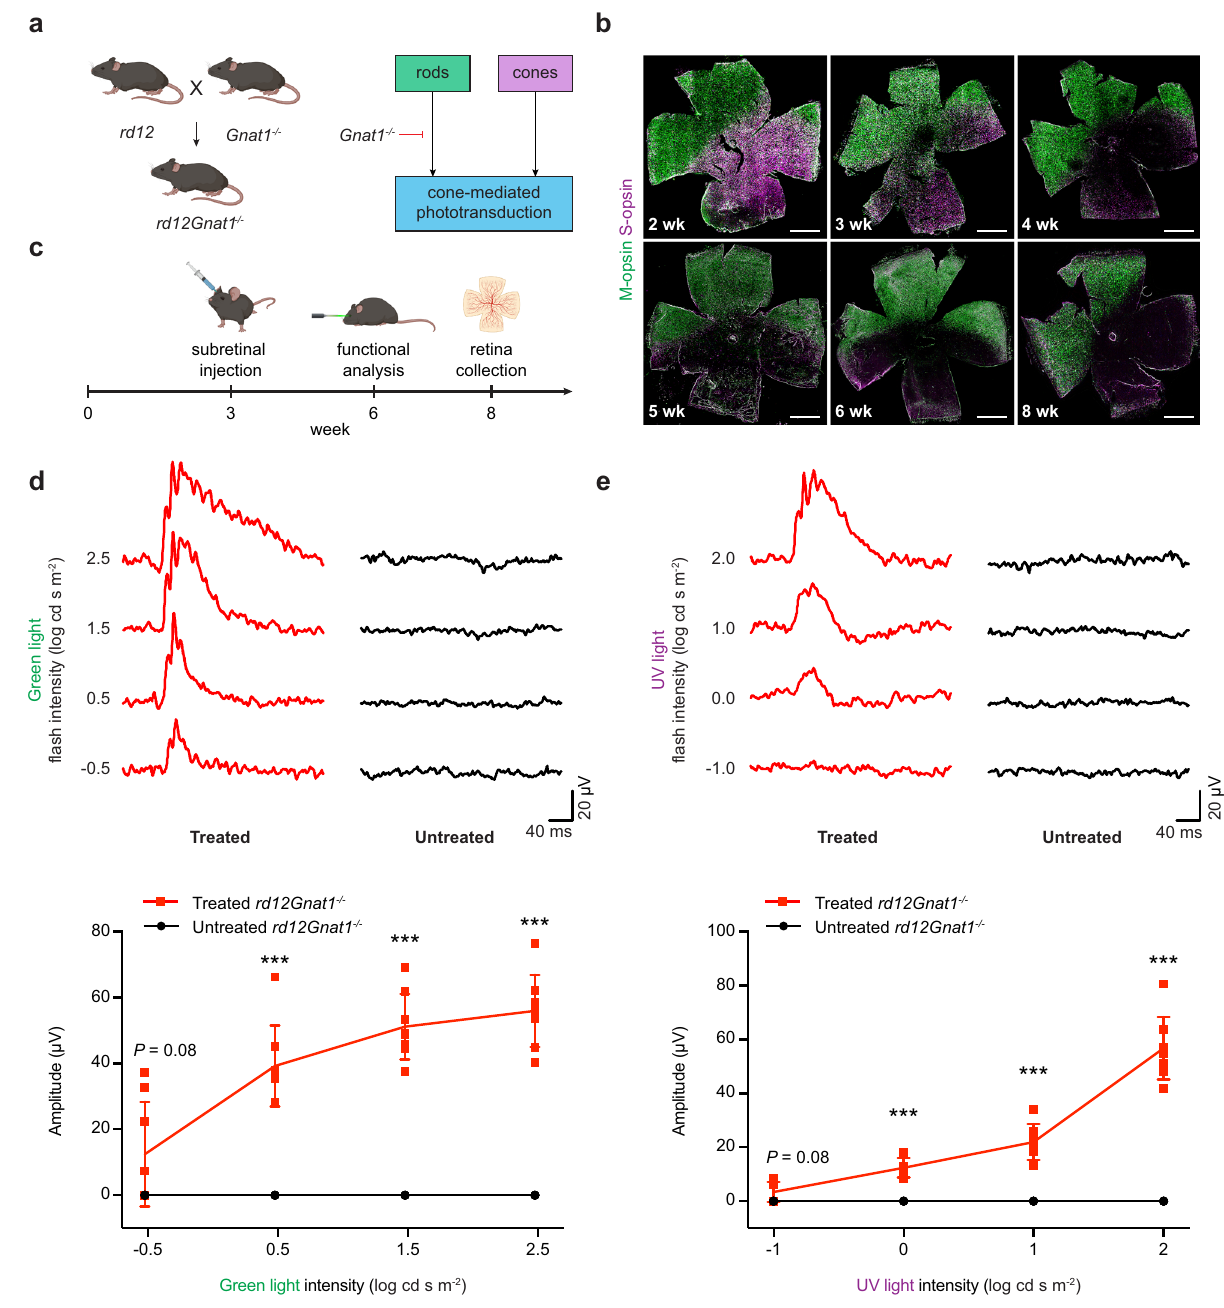
Fig. 3 Rescue of cone-mediated visual function in rd12Gnat1 − / − mice after ABE treatment. a Breeding strategy to generate a homozygous rd12Gnat1 − / − mouse line. Knockout (KO) of Gnat1 nearly completely abolishes the phototransduction signaling cascade from rods, leaving cone-mediated phototransduction. b Progression of cone degeneration in the rd12Gnat1 − / − mouse from 2 weeks of age to 8 weeks of age. M-opsin, green. S-opsin, purple. Scale bar, 1 mm. c Experimental timeline to evaluate cone function and survival in rd12Gnat1 − / − mice after ABE treatment. d Representative photopic ERG waveforms of M-cones (top) and the average b-wave amplitudes (bottom), evoked with the indicated green light fl ashes in treated and untreated rd12Gnat1 − / − mice ( n = 8, each group). Mean ± SD. *** P < 0.001; two-tailed Mann – Whitney U -test. P values are 0.08 at − 0.5 and 0.0002 at 0.5, 1.5, and 2.5 light intensities. e Representative photopic ERG waveforms of S-cones (top) and the average b-wave amplitudes (bottom), evoked with the indicated UV light fl ashes, in treated and untreated rd12Gnat1 − / − mice ( n = 8, each group). Mean ± SD. *** P < 0.001; two-tailed Mann – Whitney U -test. P values are 0.08 at − 1 and 0.0002 at 0, 1 and 2 light intensities. Source data are provided as a Source data fi